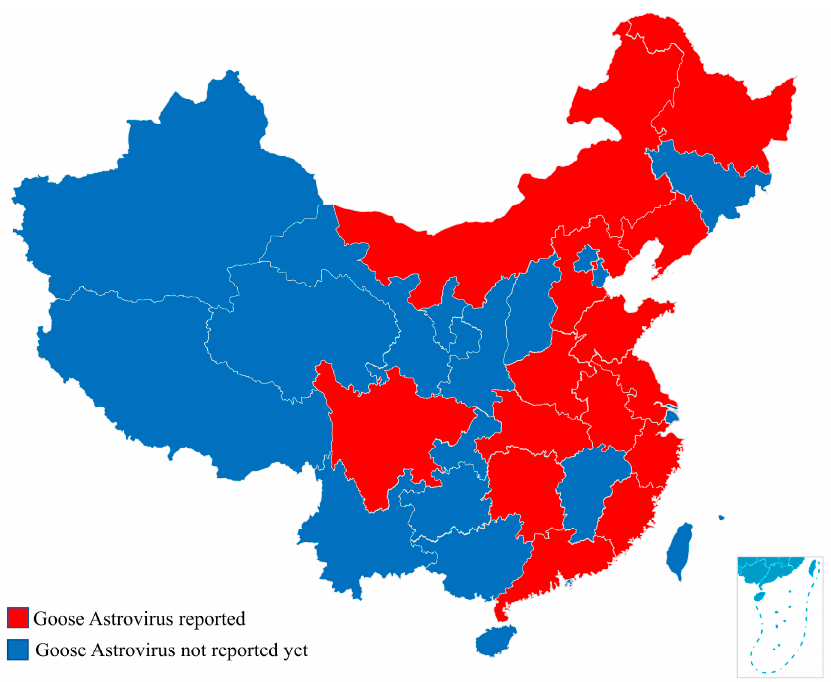
Figure 1. Provinces reporting GoAstV infections between 2014 and 2019.